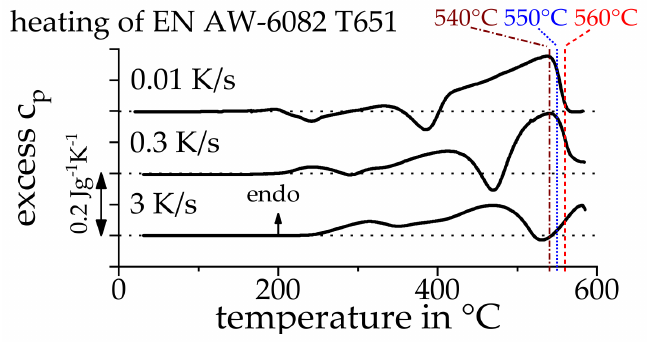
Figure 2. Differential scanning calorimetry (DSC) heating curves of EN AW–6082 initially T651 as a function of temperature. The solution temperatures chosen for later experiments are